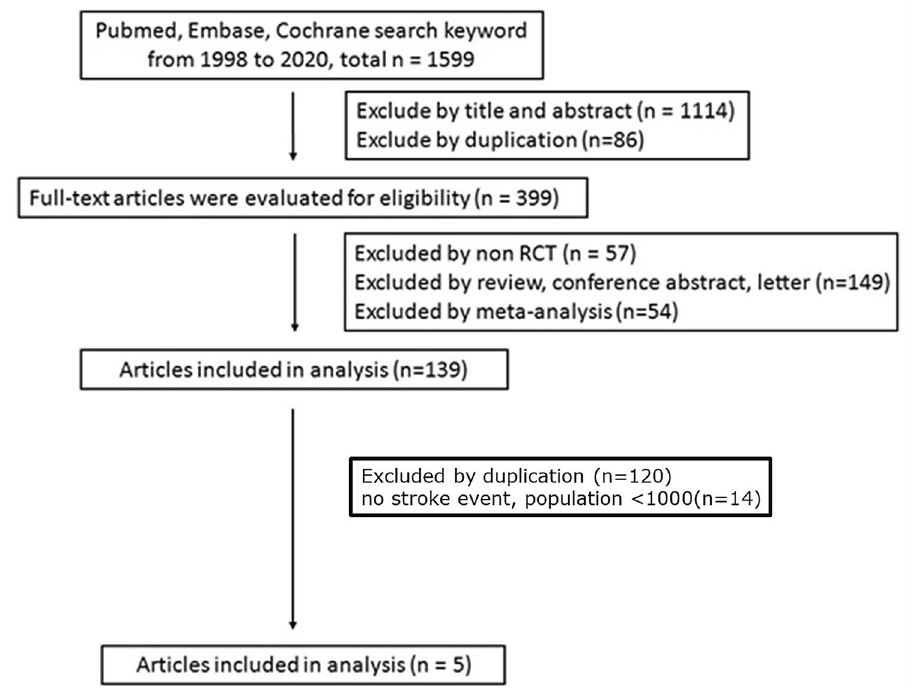
Figure 1. Flow chart showing selection of studies for